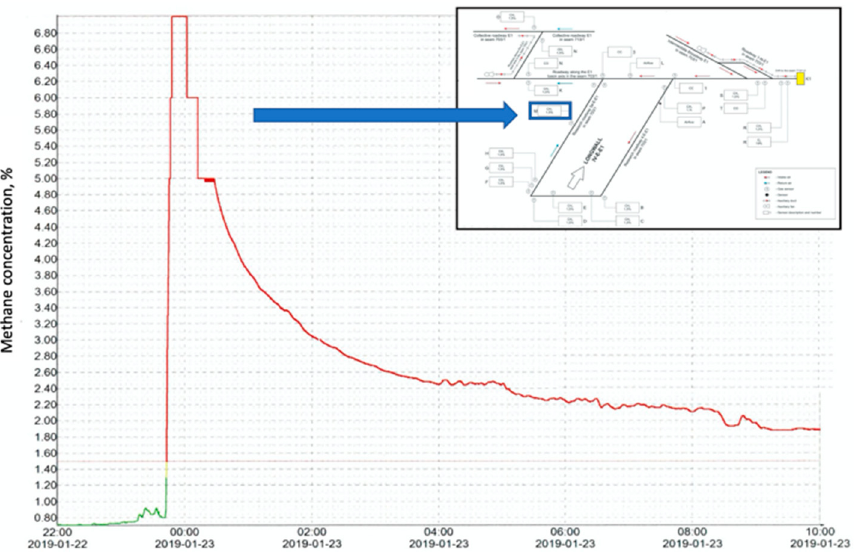
Figure 11. A change in methane concentration after the burst recorded by a CH 4 (M) sensor in- stalled in Researcher roadway 3a-E-E1 in seam 703/1 5 m ahead of a transformer (sensor M in Fig- ure 4) [3].